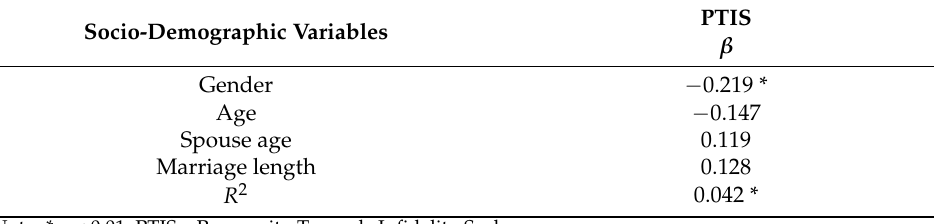
Table 4. Hierarchical regression model for PTIS.